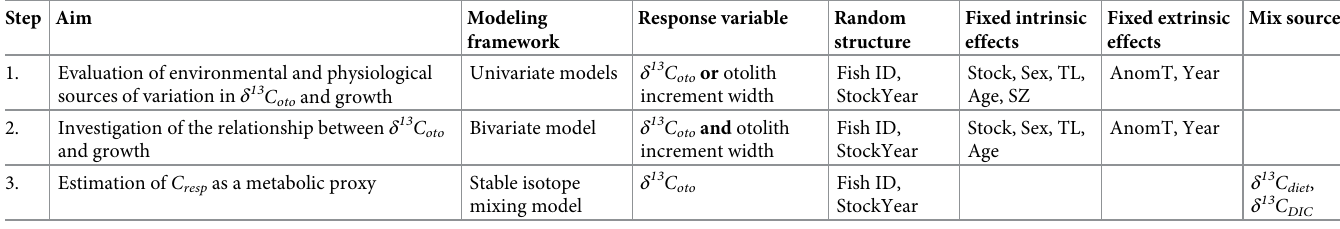
Table 1. General workflow and variables used in the consecutive steps of the statistical